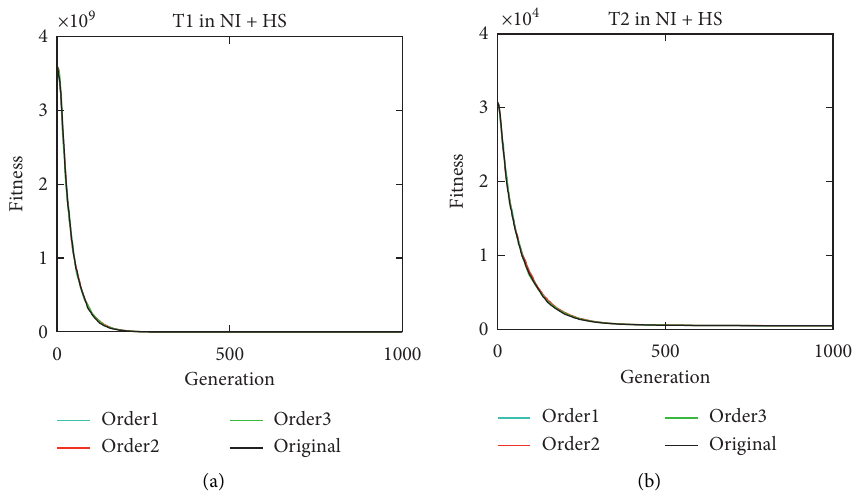
Figure 19: Convergence of MFDE for problem 7 (NI +HS).